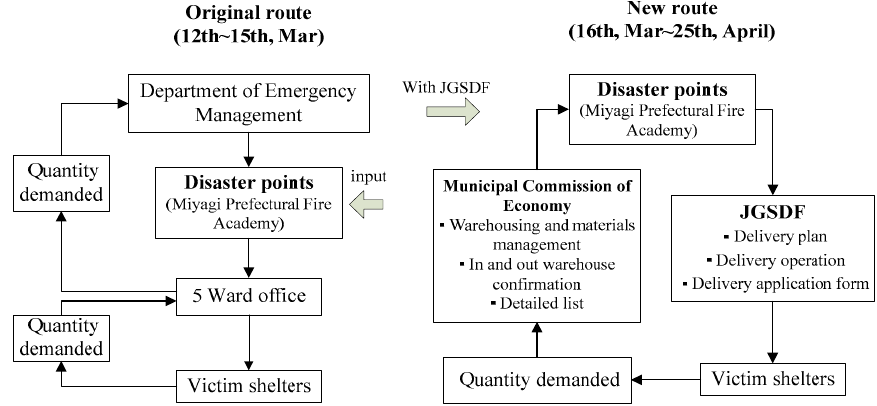
Figure 1. The scheduling process in Sendai City during the 2011 Tohoku earthquake.